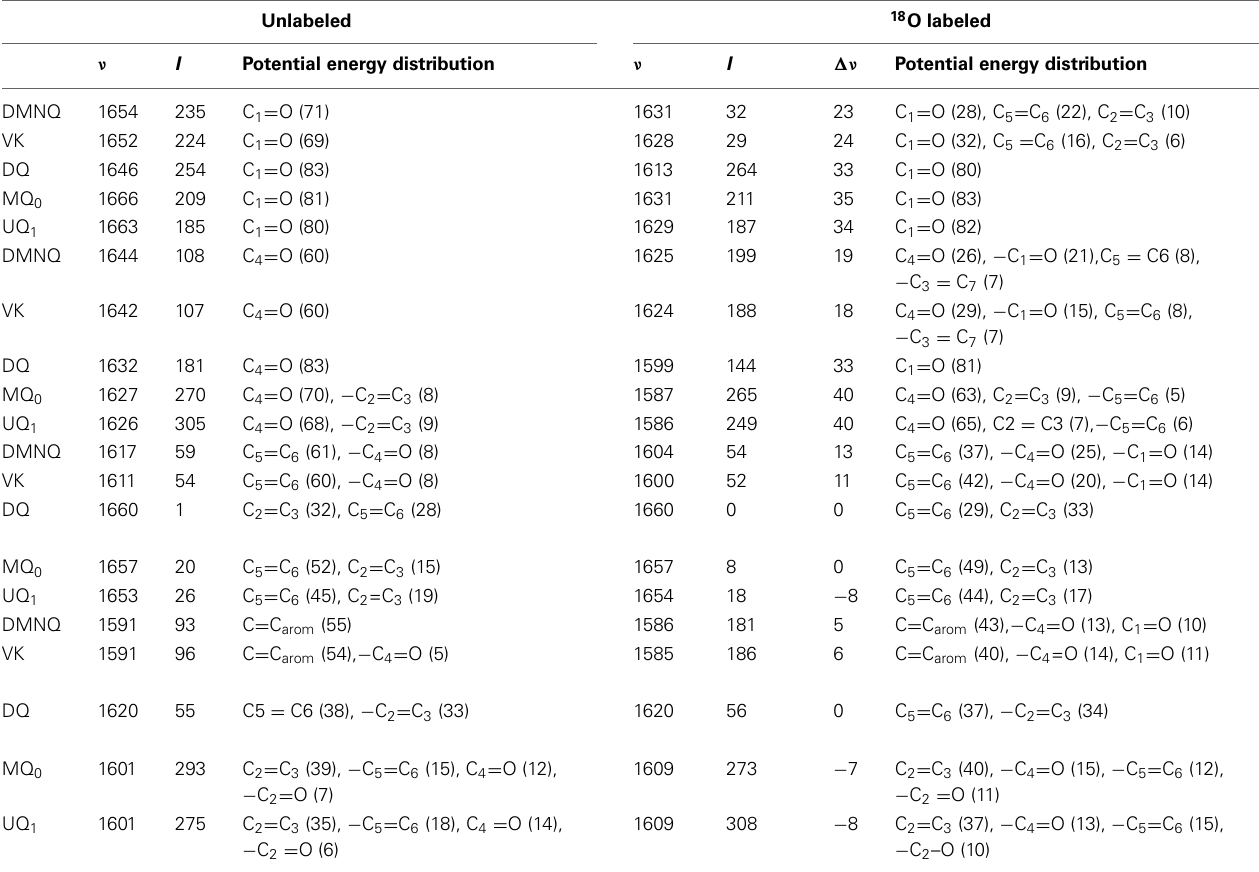
Table 2 | Normal mode frequencies (in cm − 1 ), intensities (in km/mol) and PEDs (in %) calculated using ONIOM methods for unlabeled and 18 O labeled neutral DMNQ, VK, DQ, MQ 0 , and UQ 1 . Unlabeled 18 O labeled Potential energy